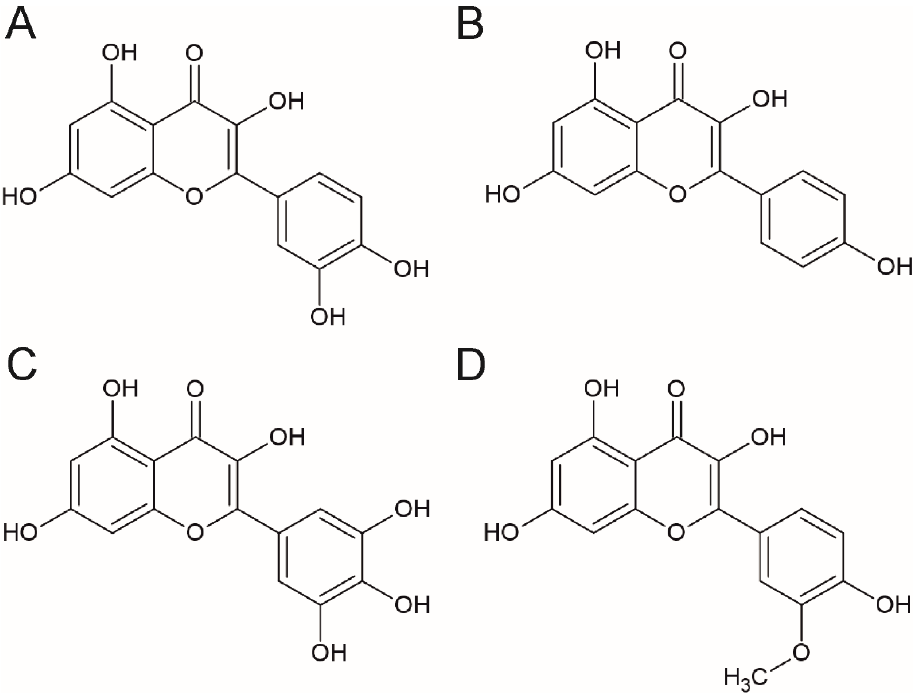
Figure 1. The chemical structure of the selected flavonols ( A ) quercetin, ( B ) kaempferol, ( C ) myricetin, and ( D ) isorhamnetin. Aglycones are generally unstable and present low solubility due to lipophilicity.